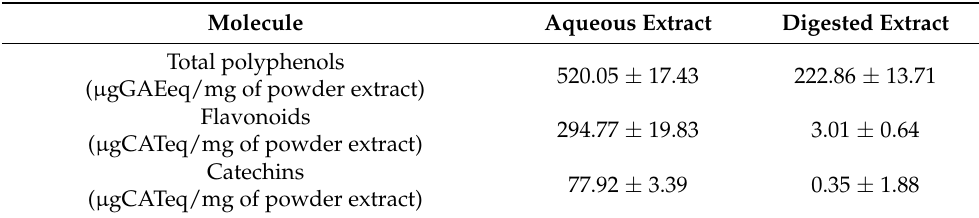
Table 1. Composition of cinnamon bark aqueous extract and after in vitro digested process used in the